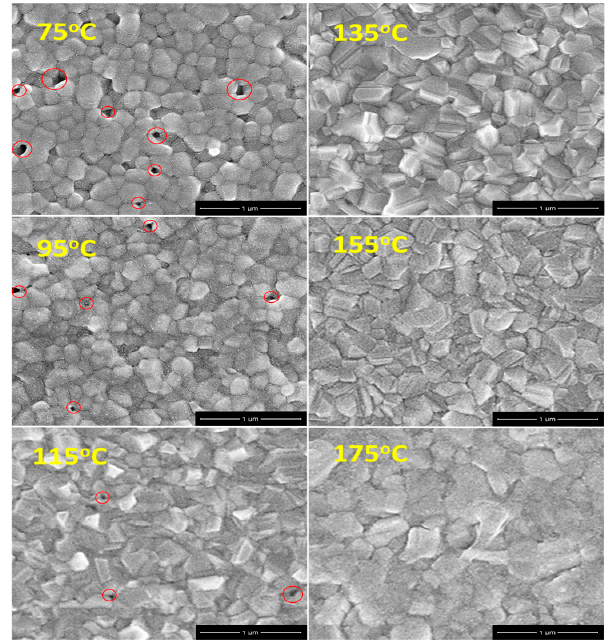
Figure 4. SEM images of (FAPbI 3 ) 0.8 (MAPbBr 3 ) 0.2 perovskite films annealed at various temperatures. Red circles indicate defect sites.